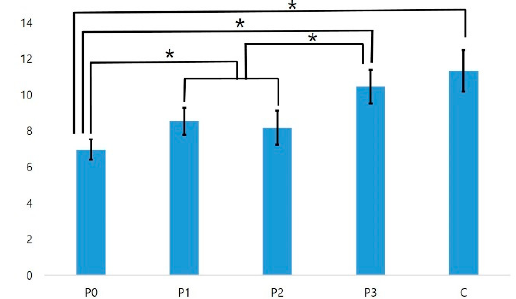
Figure 10. Biofilm thickness of Streptococcus mutans in micrometers ( n = 3). An * denotes a significant difference ( p < 0.05).